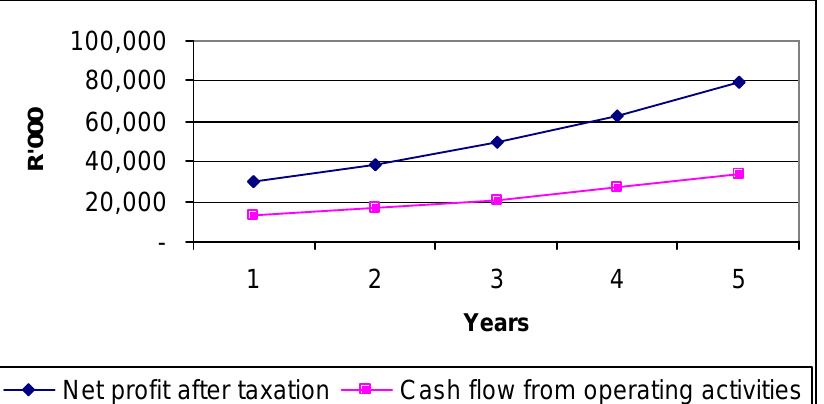
Figure 1: A high growth rate, low non-cash working capital and a high net profit ratio